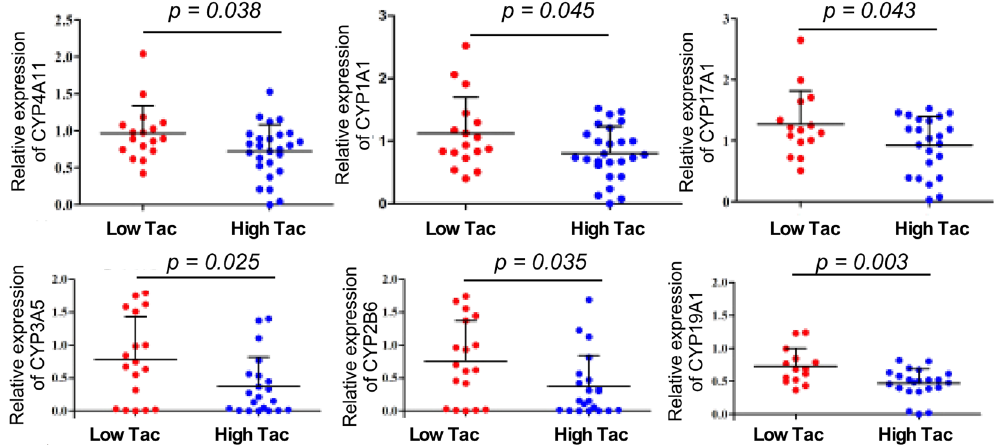
Figure 3. Validation of gene expression levels in the blood of low and the high tacrolimus (Tac) groups in liver transplant receipts. RNA from the blood of receipts was prepared for real-time PCR analysis of gene expression levels. Relative expression levels of indicated genes are shown. The average of the gene expression level from the low Tac group was set as 1, and gene expression levels in receipts were compared to this value.